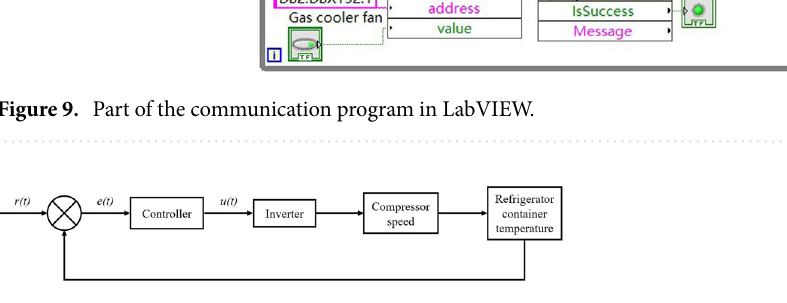
Figure 10. Compressor speed PID controller control schematic